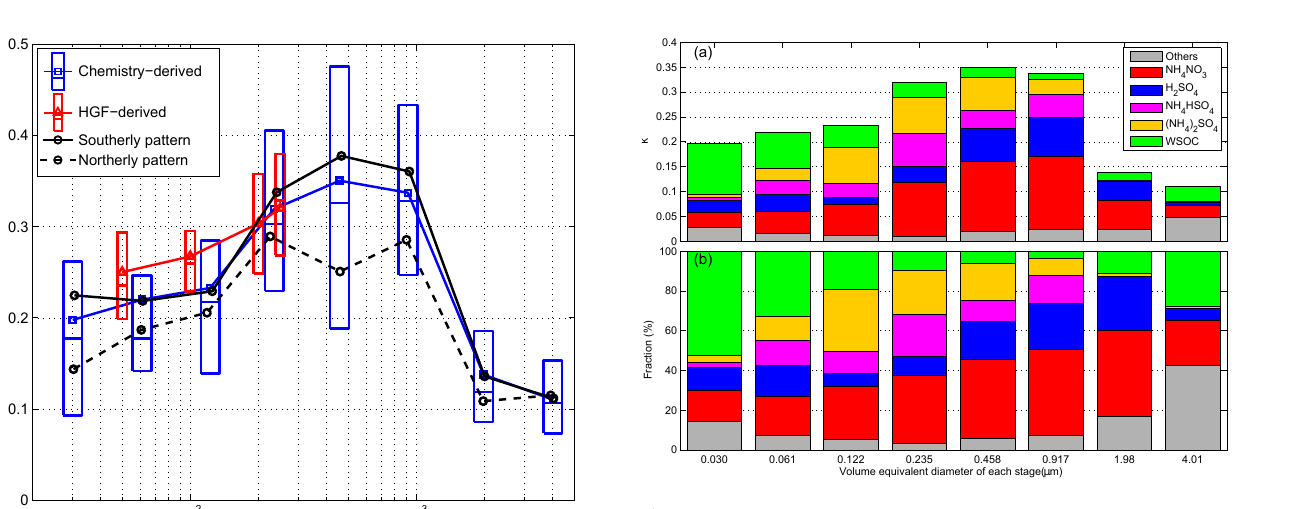
Fig. 6. Average contributions of main species to κ values. The up- per panel shows the absolute contributions of each species, and the bottom panel shows the relative contributions. WSOC and several inorganic compounds are explicitly displayed due to their signifi- cant roles in aerosol’s hygroscopic properties. Other inorganic salts are merged into a group named “Others” due to their relatively mi- nor